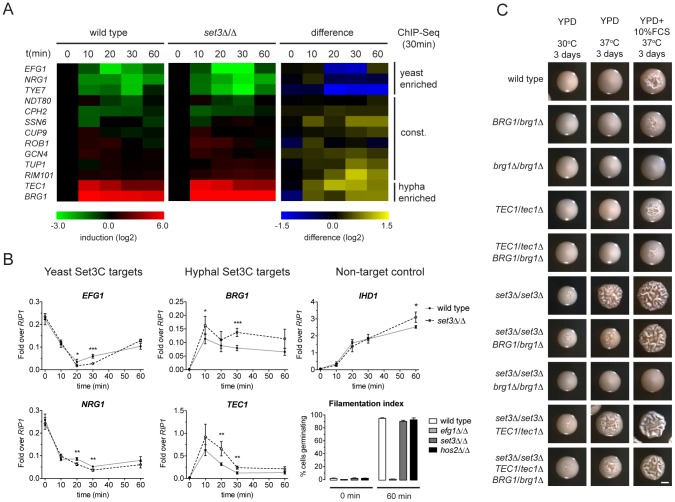
The Set3C modulates morphogenesis through a TF cluster.(A) qRT-PCR quantification of the indicated transcripts in wild type and set3Δ/Δ yeast cells induced to differentiate into hyphae 10, 20, 30 and 60 minutes after induction. The transcript levels are normalized against RIP1 expression and the level of the respective gene in yeast cells (0 min). The right panel shows the quantitative difference between the values in the two genotypes at each individual time point. Average values of four independent experiments are shown. (B) Transcript levels of BRG1, TEC1, NRG1 and EFG1 in differentiating wild type and set3Δ/Δ yeast cells as on (A) quantified by qRT-PCR. IHD1 is hyphal-induced non-Set3C-target control gene. In the bottom right panel the percentage of cells germinating at the starting cultures and 60 minutes post induction is shown as a control. Data are shown as mean+SD of four independent experiments. Statistical significance was determined by two-tailed t-test. *P<0.05, **P<0.01, ***P<0.001. (C) Removal of one BRG1 allele reverts hyperfilamentation of set3Δ/Δ cells under intermediate inducing conditions. Shown are photographs of single colonies. YPD at 30°C supports yeast-phase growth, YPD+FCS at 37°C supports hyphal growth, YPD at 37°C represents “intermediate” conditions. Scale bar corresponds to 2 mm.